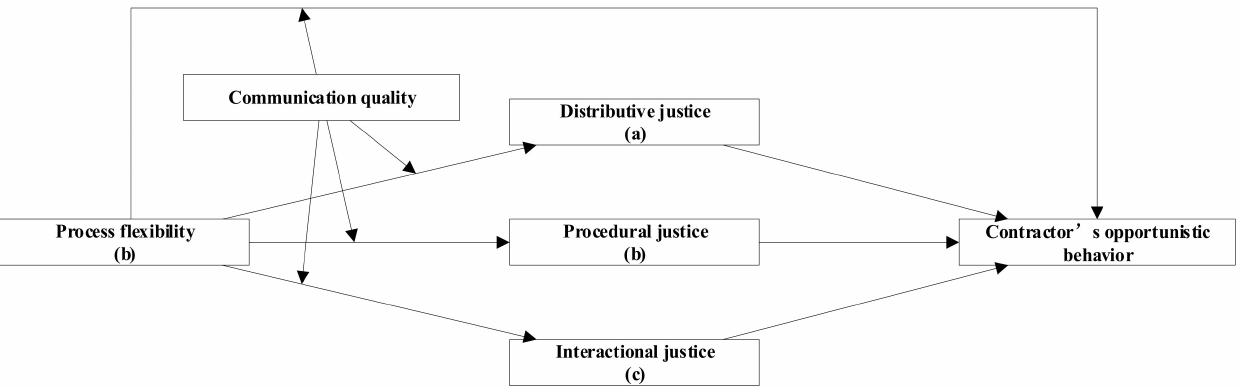
Figure 4. Diagram B of the model